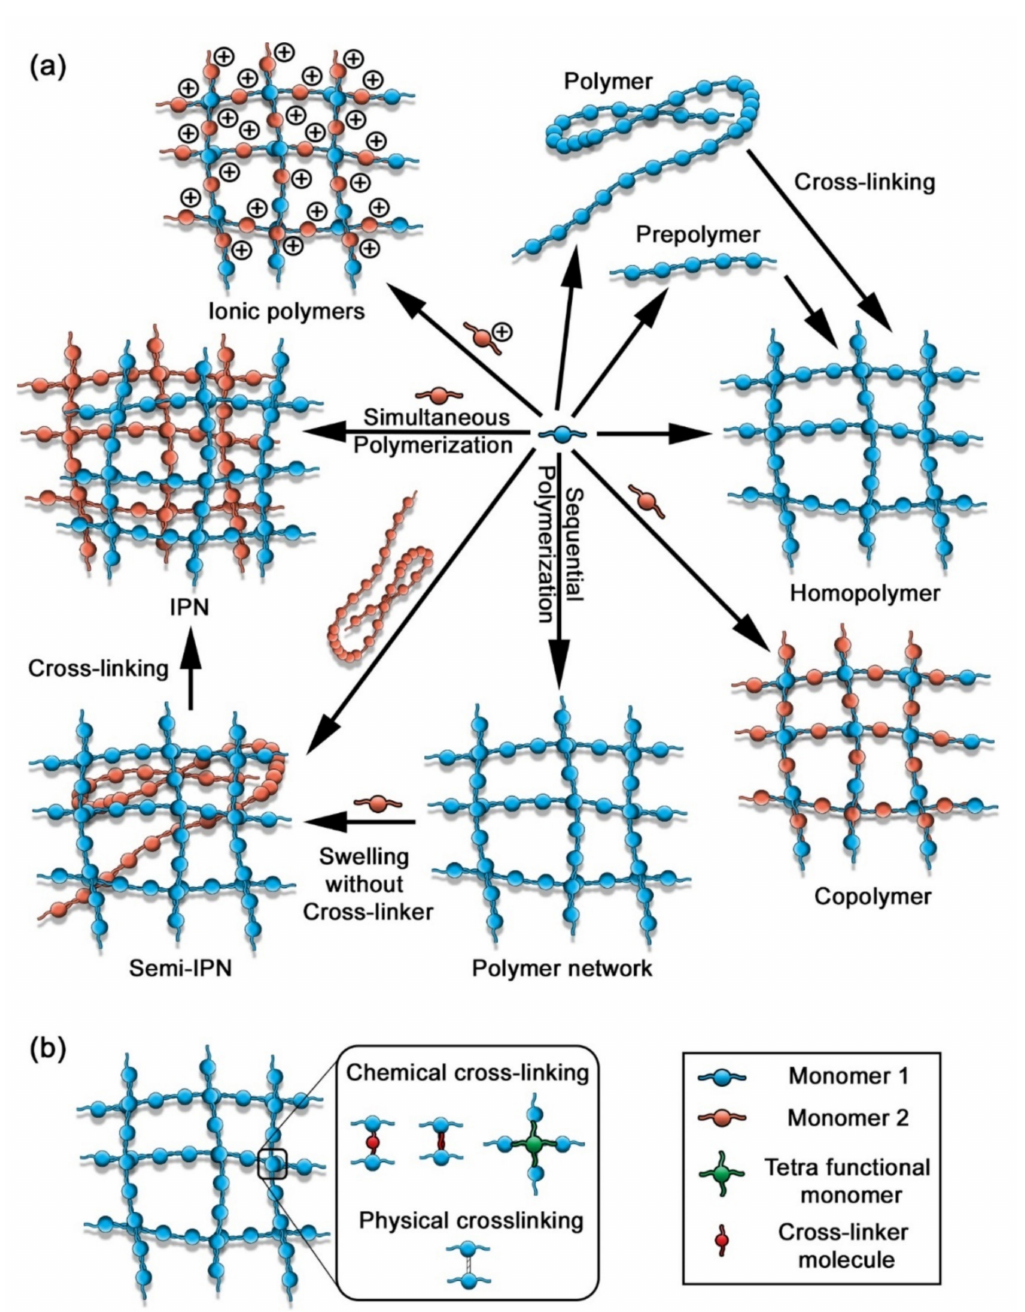
Figure 9. ( a ) Representation of different types of synthetic hydrogels with the methods of preparation for each type. ( b ) Different ways of crosslinking between polymer chains in a hydrogel which are between horizontal and vertical polymer chains. Reprinted with permission from reference